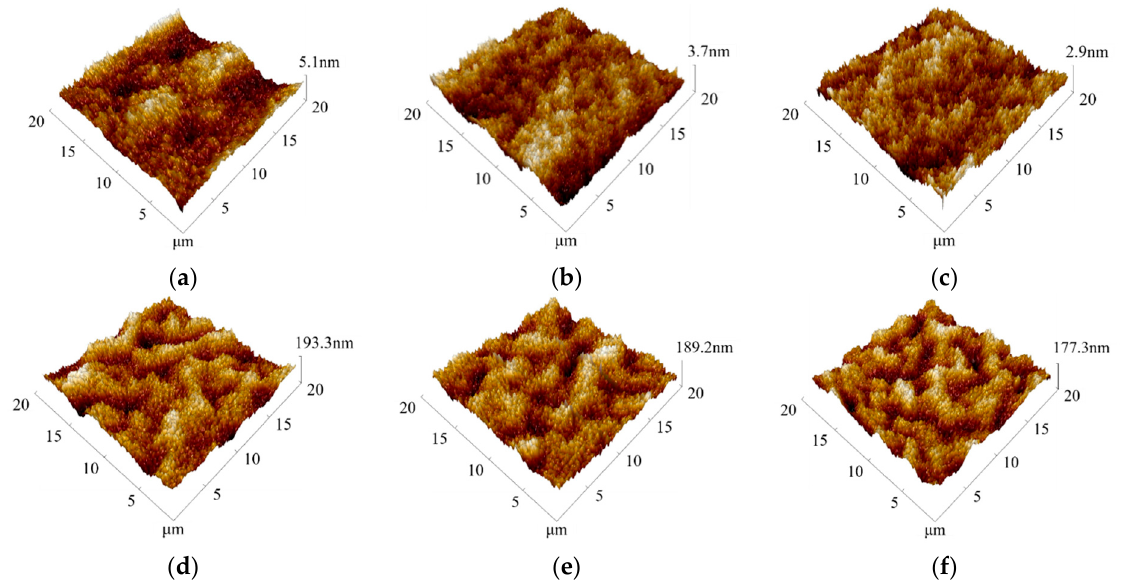
Figure 6. Atomic force microscope (AFM) surface morphology of the PDMS thin films and the MoS 2 thin films deposited on PDMS at different rotation speeds. ( a – c ): AFM surface morphology of the PDMS thin films at rotational speeds of 0, 500, and 1000 r/min, respectively; ( d – f ): AFM surface morphology of the MoS 2 thin films deposited on PDMS.